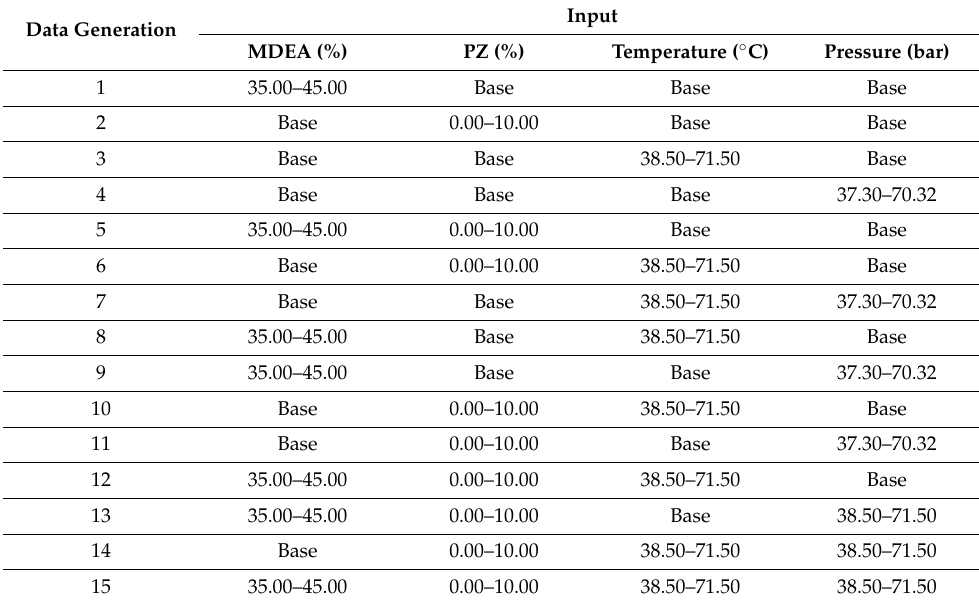
Table 4. Data generation framework with respect to their input and their